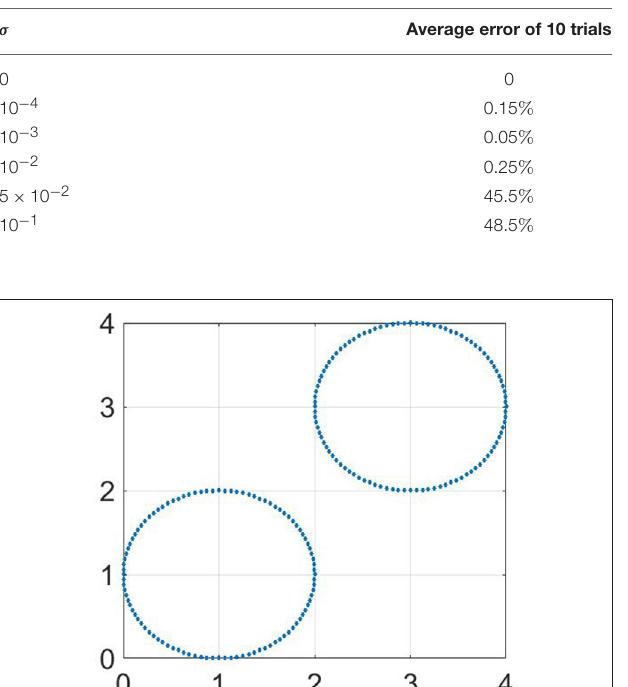
TABLE 2 | Results of testing for two moons dataset embedded in R 100 , n = 200, m = 2.